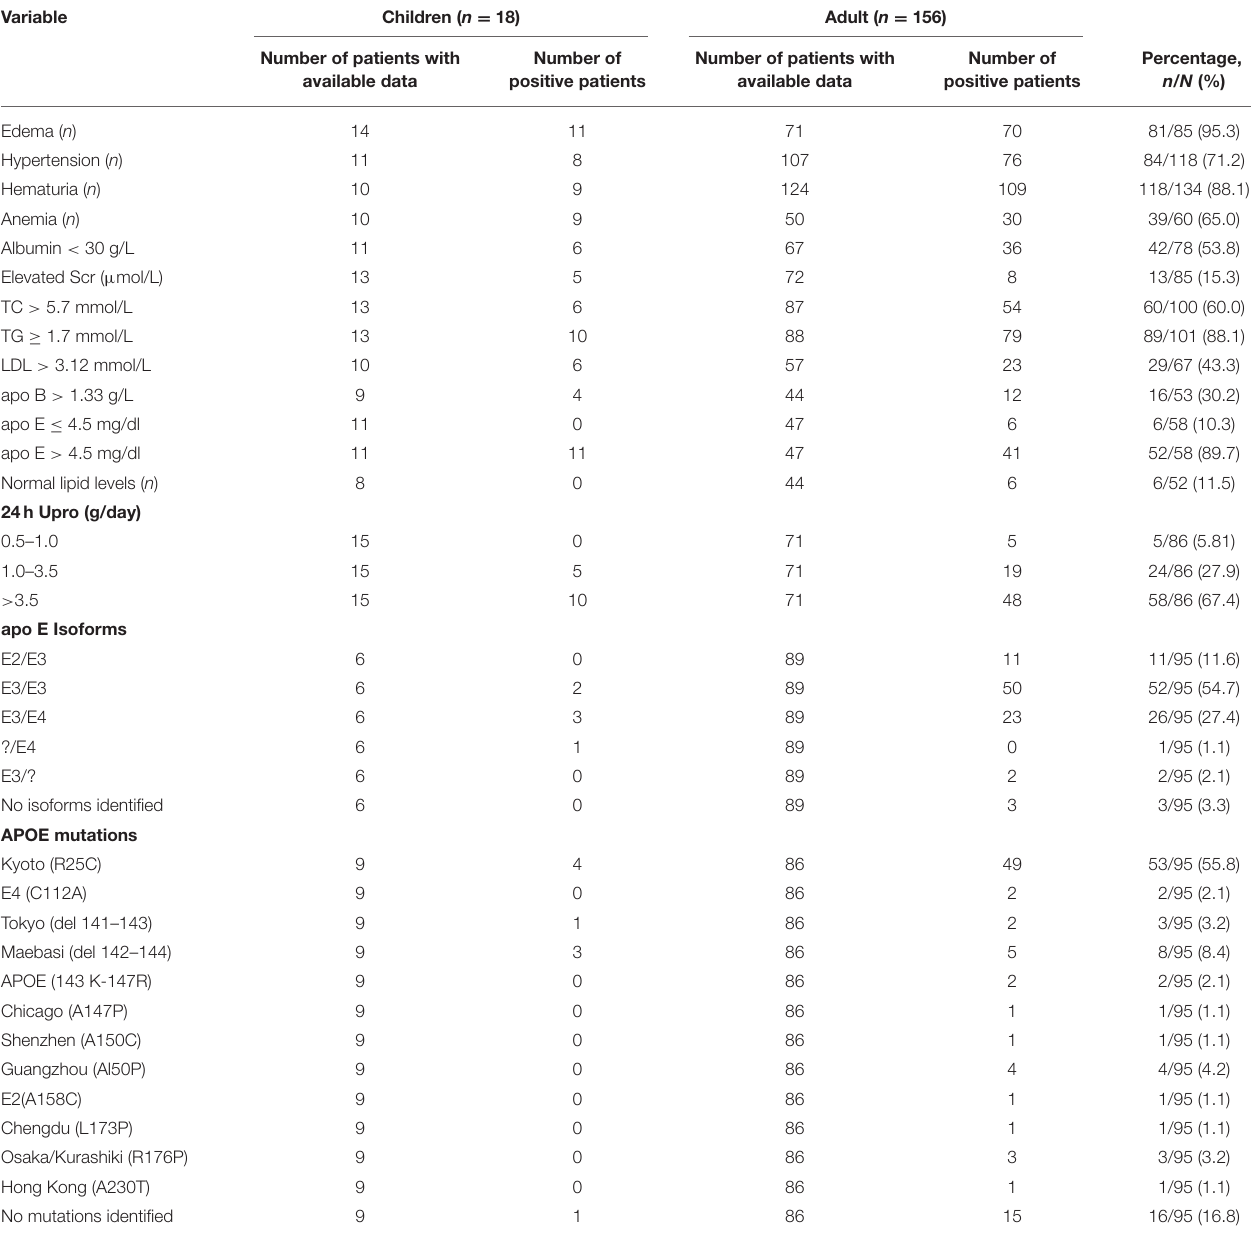
TABLE 2 | Clinical features and genetic characteristics of Chinese LPG patients. Variable Children ( n = 18) Adult ( n = 156)